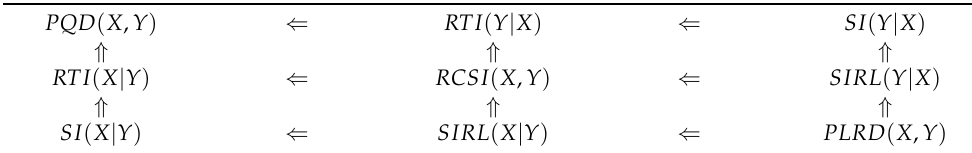
Table 2. Relationships among positive dependence properties.